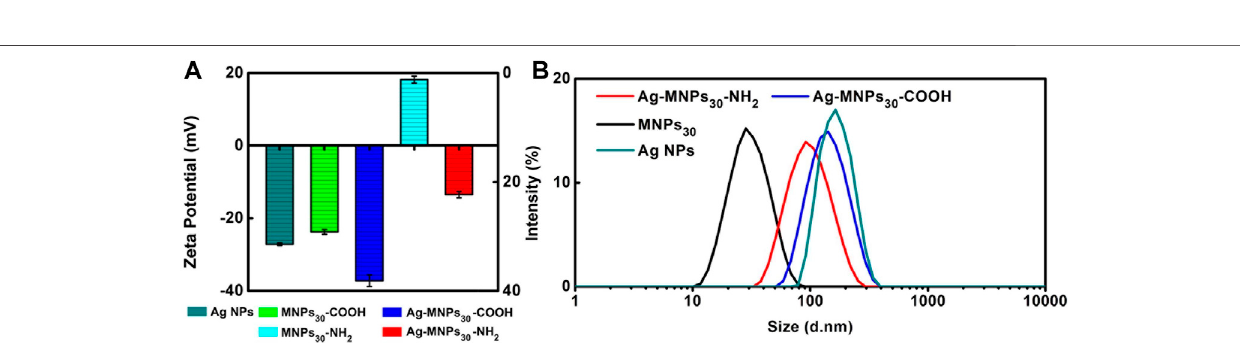
FIGURE 4 | (A) Zeta potentials of Ag NPs, MNPs 30 -COOH, Ag-MNPs 30 -COOH, MNPs 30 -NH2, and Ag-MNPs 30 -NH2. (B) DLS analysis of Ag NPs, MNPs 30 - COOH, Ag-MNPs 30 -COOH, MNPs 30 -NH2, and Ag-MNPs 30